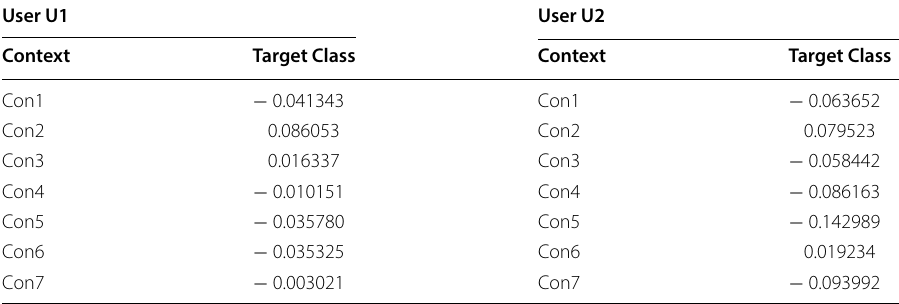
Table 6 Correlation coefficient with target class utilizing the dataset of user U1 and